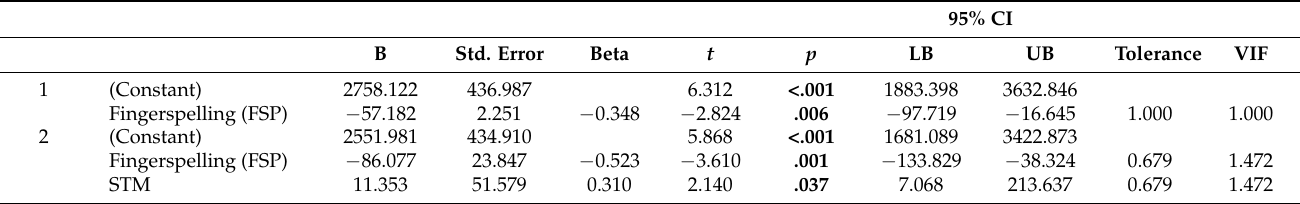
Table 5. Regression coefficients for word RTs at T2. Significant predictors are